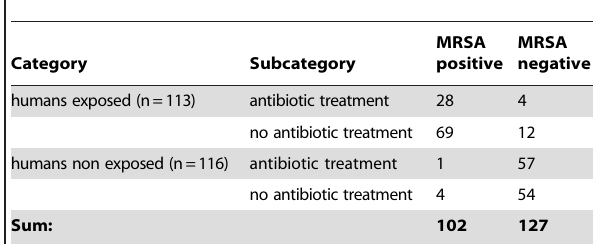
Table 3. Antibiotic treatment previous to sampling of pig farmers and of their non exposed familial contact